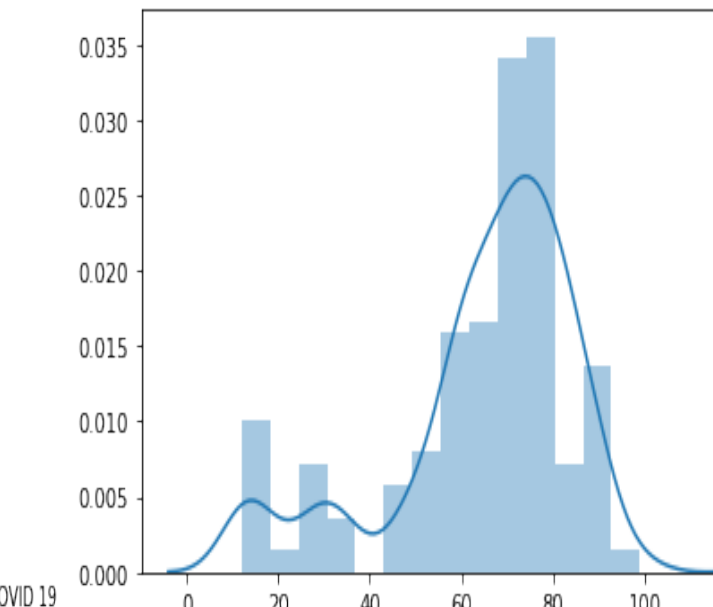
Figure 5. Time spent on activity during COVID 19